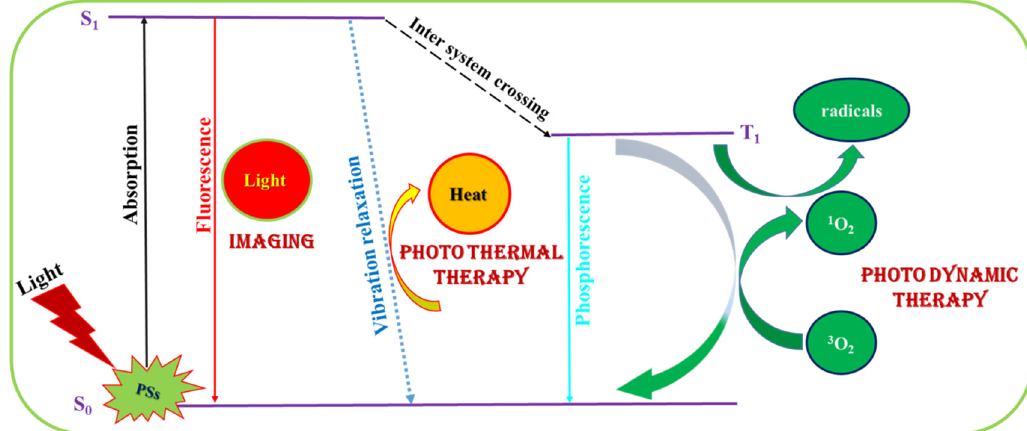
Figure 1. The Jablonski diagram showing the process of fluorescence imaging as well as photothermal therapy and photodynamic therapy when a photosensitizers (PS) is irradiated with light.